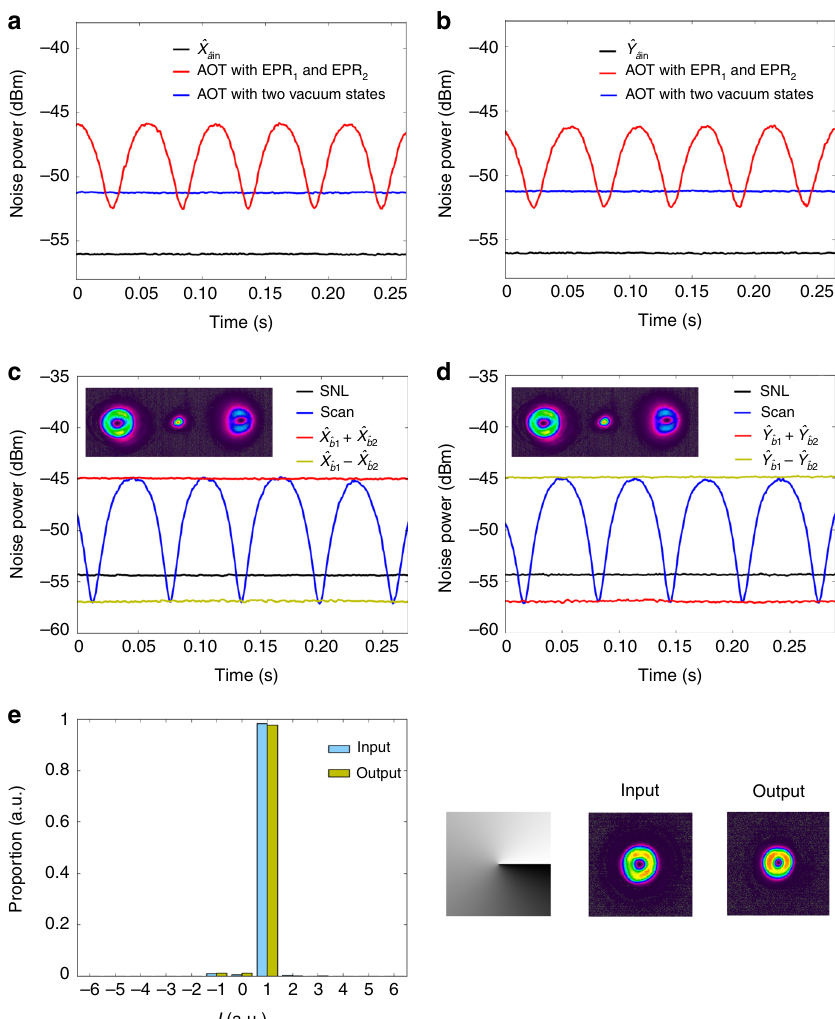
Fig. 3 The quadrature variances of the retrieved state for ℓ = 1. a , b The variance of amplitude (phase) quadrature of the retrieved state. c , d The amplitude (phase) quadrature measurement of the orbital angular momentum (OAM) multiplexed entanglement source. The yellow trace is the variance of amplitude (phase) quadrature difference. The red trace is the variance of amplitude (phase) quadrature sum. The blue curve is noise power of the photocurrents output from balanced homodyne detection (BHD) versus the scanning phase. The black trace represents the corresponding shot noise limit (SNL). The insets show the transverse pattern of the output fi eld when the four-wave mixing (FWM) is seeded by a bright beam. The left, center, and right beams are ^ b 1 ; 1 , Gaussian pump beam, and ^ b 2 ; (cid:2) 1 , respectively. e The results of OAM mode analysis. The computer-generated hologram for ℓ = 1 case and the corresponding images of input and output fi elds are shown on the right inset,